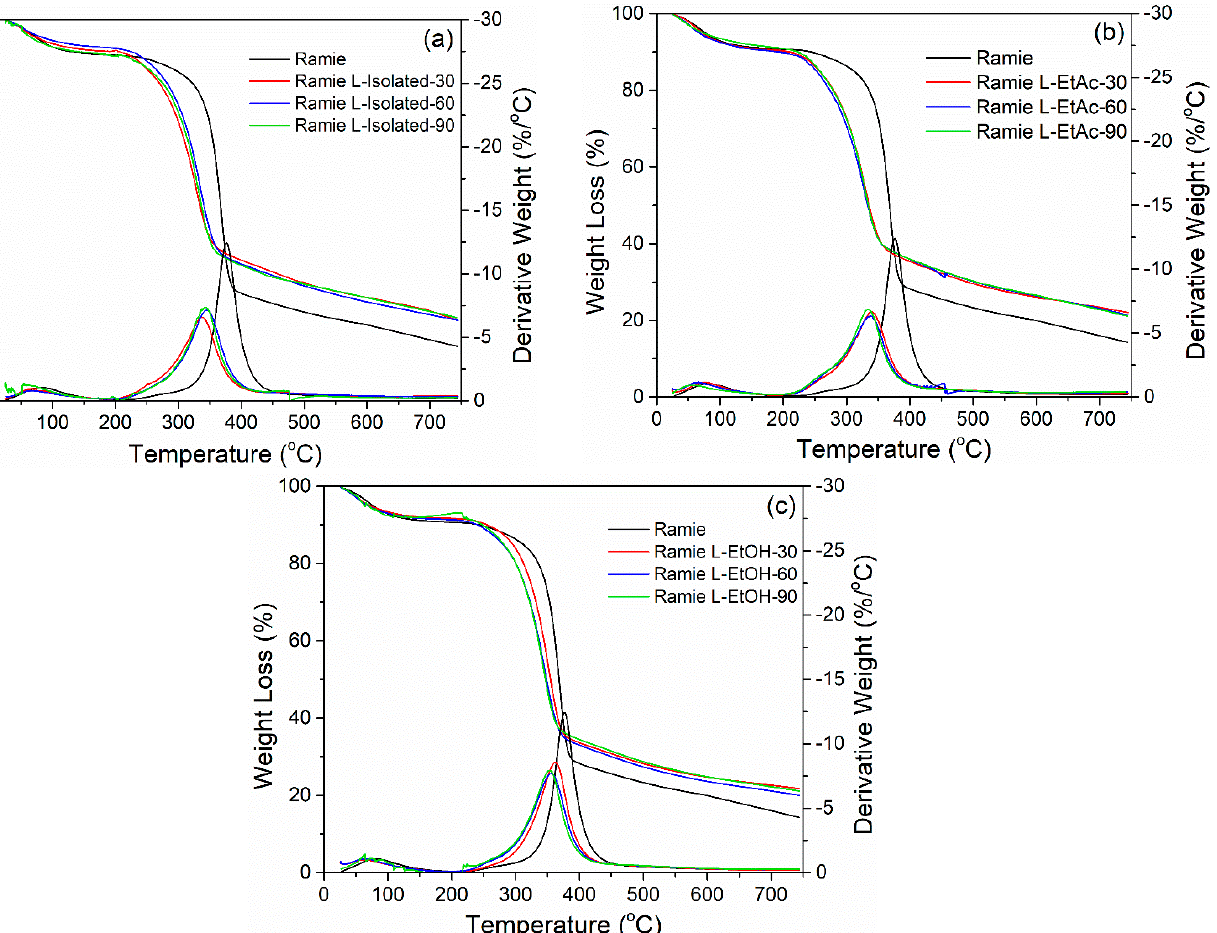
Figure 9. TGA—DTG of before and after impregnation of ramie fiber with lignin-based bio-PU: ( a ) ramie impregnated with L-Isolated, ( b ) ramie impregnated with L-EtAc, ( c ) ramie impregnated with L-EtOH.